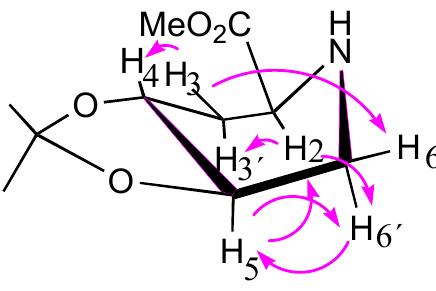
Figure 2. Key NOE correlations for compound 8 .